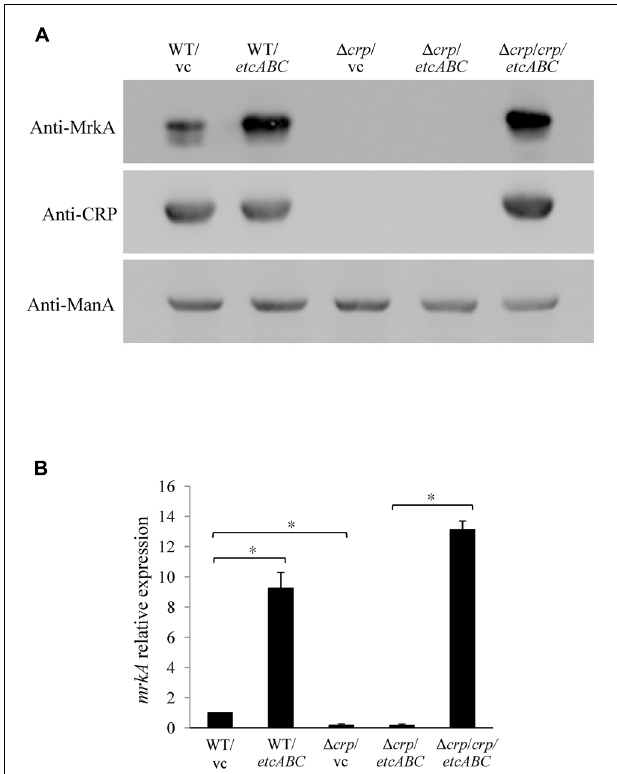
FIGURE 3 | The effects of EtcABC overexpression on MrkA was dependent on CRP. (A) Western blot analysis of MrkA, CRP, and ManA expression in each strain grown in LB. ManA was used as the loading control. The blots are representatives of at least three independent experiments. (B) RT-qPCR analysis of mrkA transcription in each strain grown in LB. The 16S rRNA gene was used as the reference. The transcriptional level of mrkA in each strain was compare to WT/vc. The presented results are the means ± standard deviations of three replicates. An asterisk ( ∗ ) represents p < 0.05 as compared with WT/vc or (cid:49) crp/crp/etcABC compared with (cid:49) crp/etcABC . WT/vc: K. pneumoniae STU1 carrying pBSK-Gm as the vector